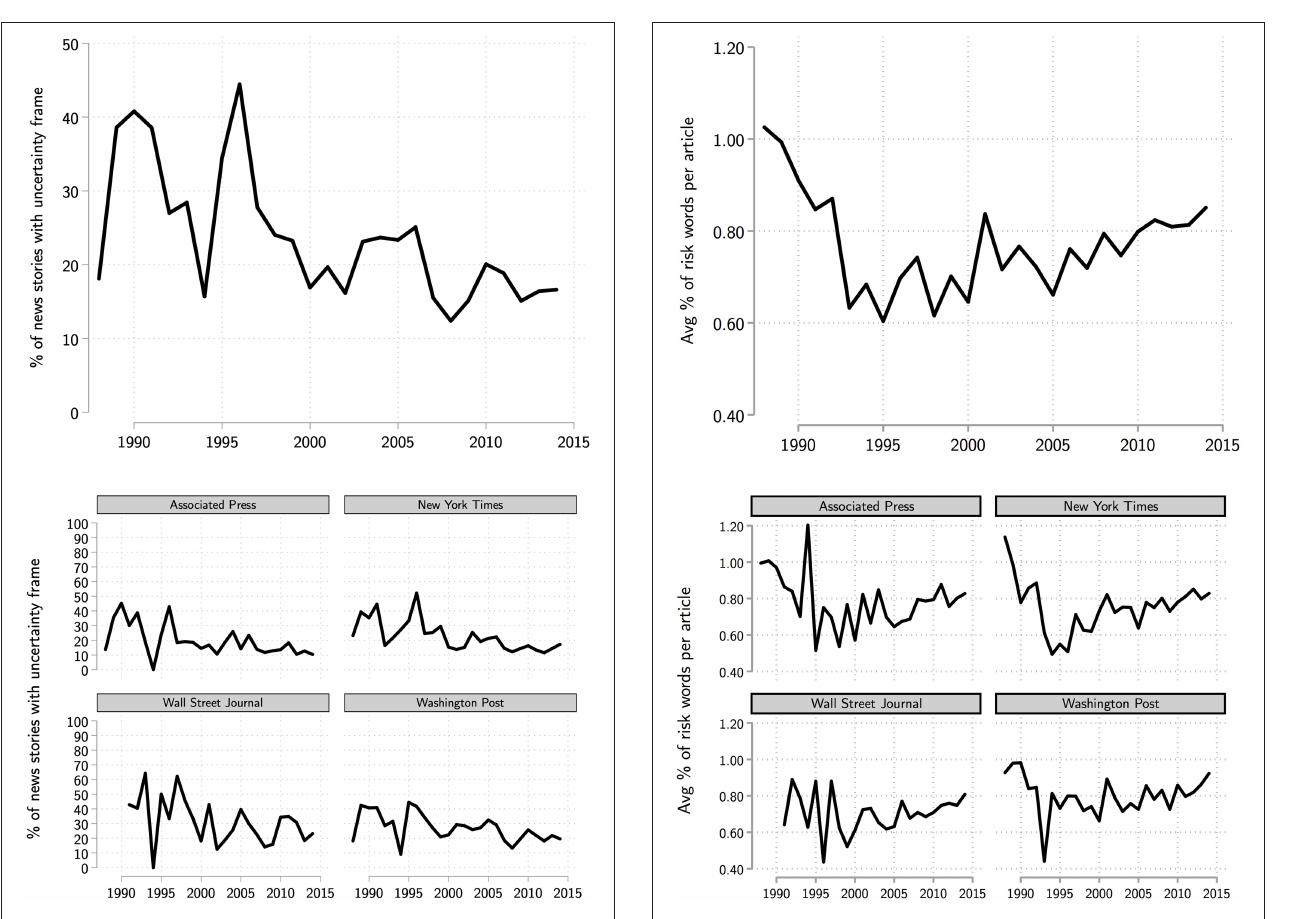
FIGURE 3 | Proportion of climate change news coverage with uncertainty framing from 1988 to 2014 in our combined corpus (top panel) and by source (bottom panels).